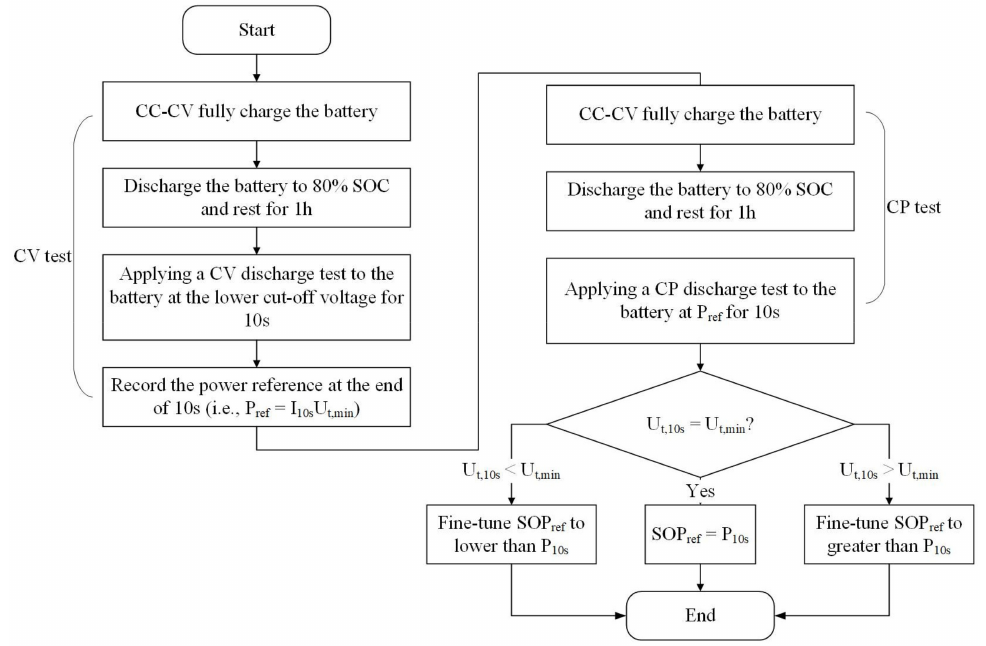
Figure 20. Test flow of the CVCP test at 80% SOC.